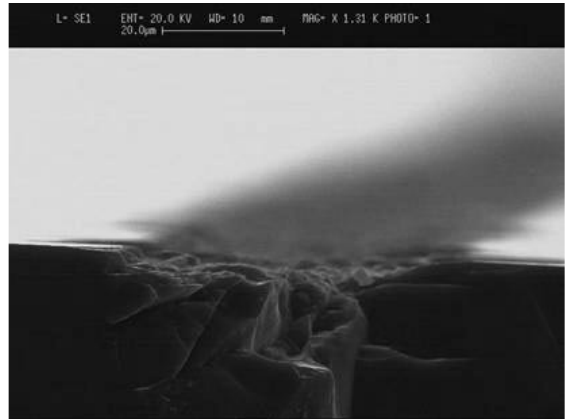
FIG. 3. Microscratch-induced deformations propagating in the bulk of the Si crystal.